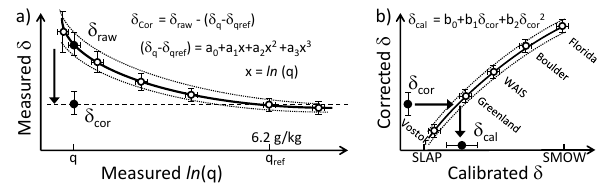
Fig. A1. Schematic depiction of calibration approach. (a) Raw mea- surements ( δ raw ) are corrected for instrument dependence on hu- midity by applying an adjustment based on a (cubic) curve fit to standard water measured at different mixing ratio values. This stan- dardizes δ measurements to a reference mixing ratio q ref = 6 . 2 gkg − 1 . (b) Corrected values ( δ cor ) are adjusted to the SMOW- SLAP scale to produce the calibrated values ( δ cal ) using a calibra- tion curve constructed as quadratic fit between values measured at q = q ref and known values of five working standards. Open sym- bols indicate measurements of standards and solid symbols show an observation. Solid arrows indicate the corrections. Values a and b are regression coefficients. All uncertainties are propagated using a Monte Carlo ensemble with 10000 members for each measure- ment to give an estimate of accuracy. Error bars denote one stan- dard deviation, and are greatly exaggerated to aid in the illustrative depiction. Dotted lines indicate the one standard deviation envelope on estimates of the calibration curves. Instrument precision is deter- mined from laboratory